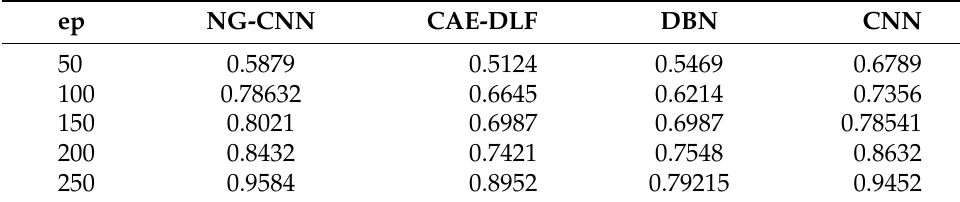
Table 1. Comparison of classification test accuracy of NG-CNN with existing methods.